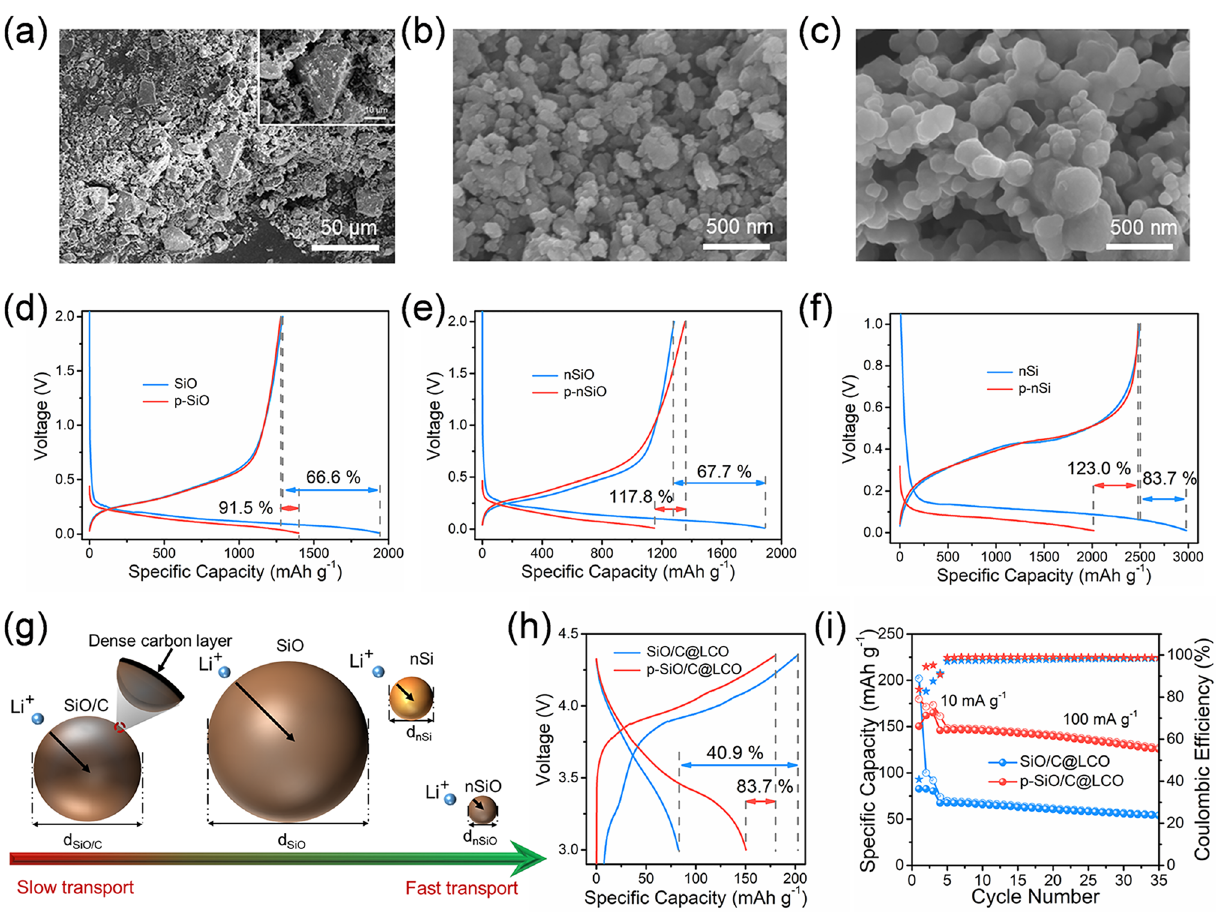
Fig. 4 SEM images of a SiO, b nSiO, and c nSi particles. Initial discharge–charge profiles of d SiO and p-SiO anodes, e nSiO and p-nSiO anodes, and f nSi and p-Si anodes. g Influencing factors of prelithiation efficiency of SiO/C, SiO, nSiO, and nSi anodes. h Initial charge–dis- charge profiles and i cycle performances of SiO/C@LCO and p-SiO/C@LCO full